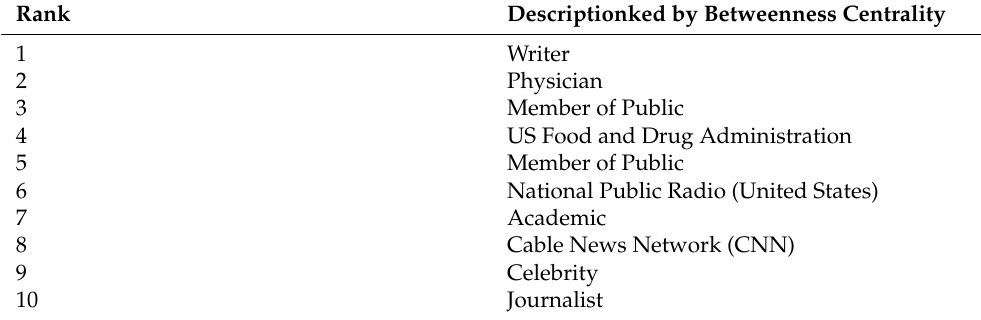
Table 4. Overview of Influential Users within the